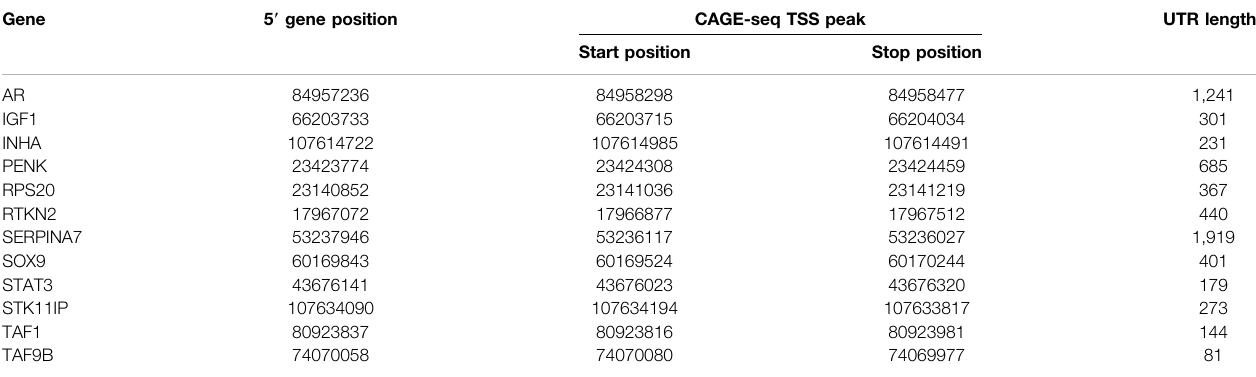
TABLE 4 | Position and length of 5 ′ untranslated